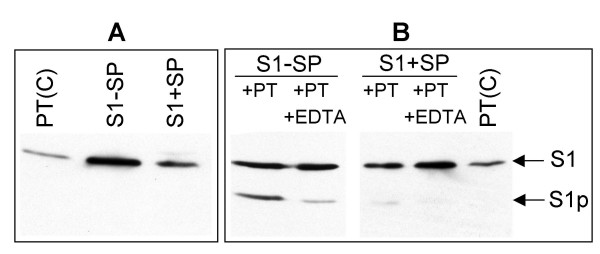
S1 processing in CHO cell transfectants expressing S1. (A) Western blot showing lack of processing of endogenous S1 in transfectants expressing S1 in the cytosol (S1-SP) or in the ER (S1+SP). (B) Western blot showing EDTA-inhibitable processing of S1 after exogenous addition of purified PT (20 nM) to these transfectants.